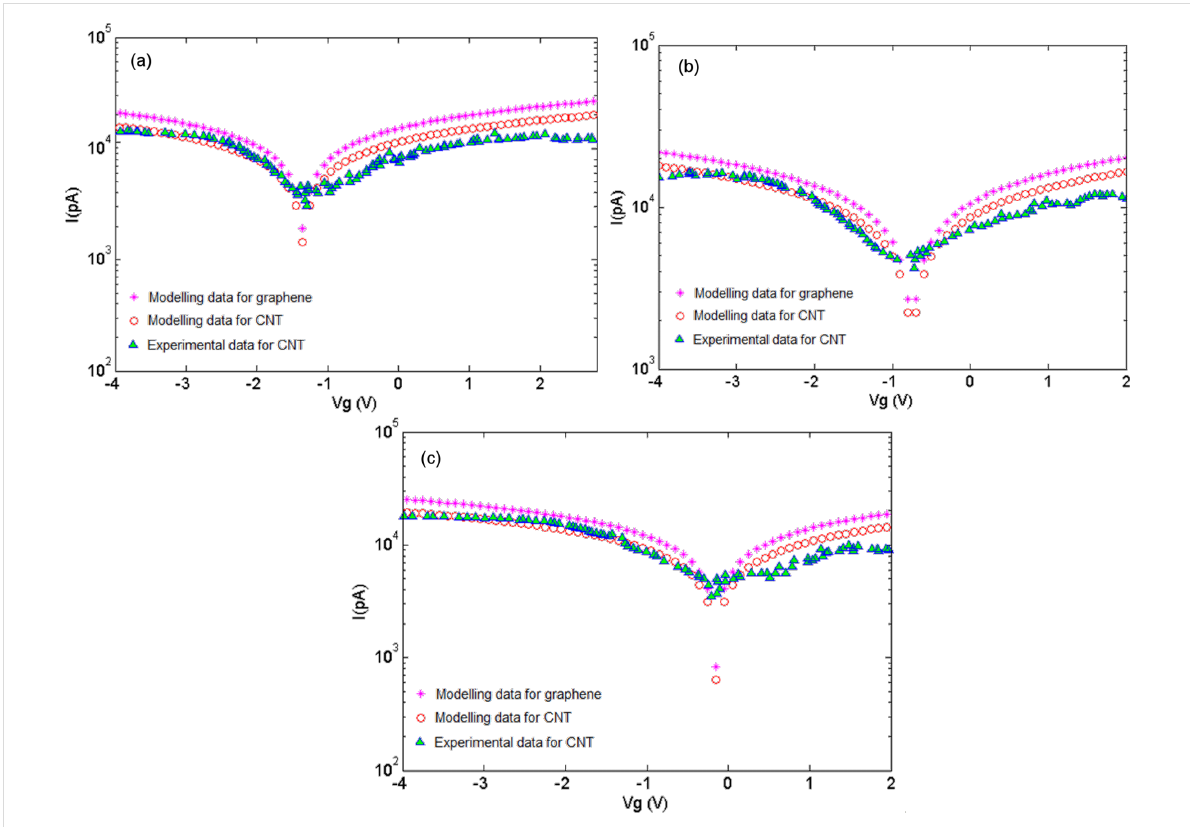
Figure 5: I – V characteristics after exposure to NH 3 for graphene and CNT at T = 200 °C and under (a) F = 100 ppm, (b) F = 200 ppm, (c) F = 500